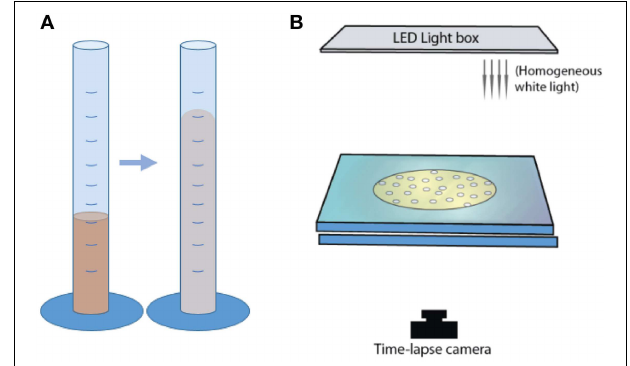
FIGURE 6 | Experimental set-up for in situ bubble growth using chemical reactions, in (A) graduated cylinders, and (B) parallel-plate